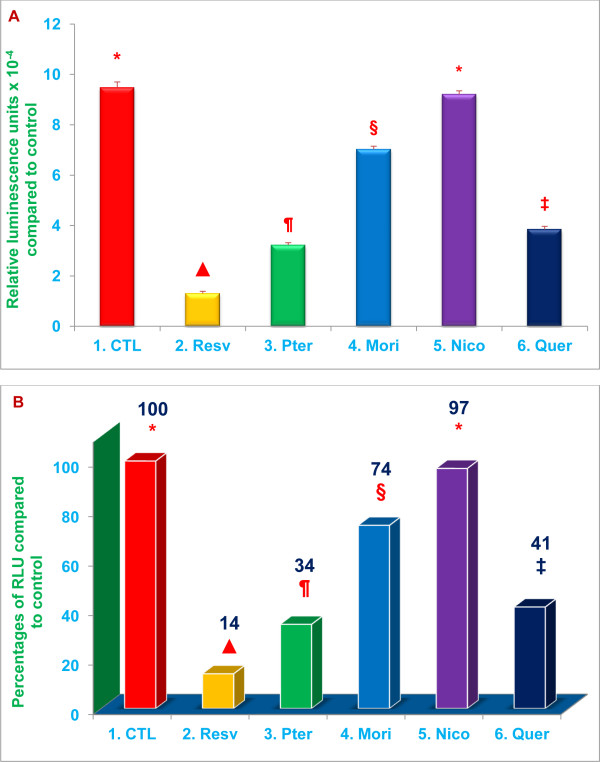
Resveratrol, pterostilbene, morin hydrate, and quercetin inhibit trypsin-like proteasomal activity. Relative trypsin-like activity was quantitated by measuring luminescence after treatment of RAW 264.7 whole cells (1x104 cells/well) with 20 μM of resveratrol, pterostilbene, morin hydrate, nicotinic acid, or quercetin. Cell viability exceeded 95% in all the treatments. Data are means ± SD, n = 3 per treatment, and triplicate analyses of each sample were performed. Values in a column not sharing a common symbol are significantly different at P < 0.05. CTL = Control (Medium + RAW 264.7 whole cells + 0.2 % DMSO); Resv = Resveratrol; Pter = Pterostilbene; Mori = Morin hydrate; Nico = Nicotinic acid; Quer = Quercetin-HCL. Figure A = Actual Relative Luminescence Unit (RLU) values. Figure B = Percentages of actual RLU values compared to control.